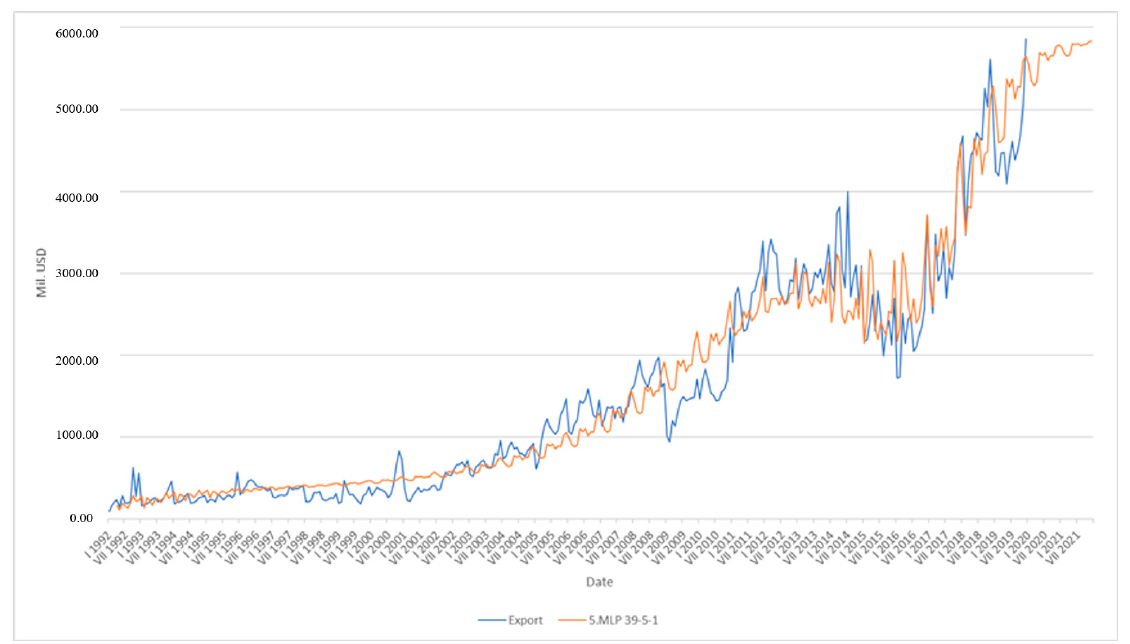
5 Figure 4. Comparison of export and equalized time series of RF export to PRC with prediction until December 2021 (Source: Author).